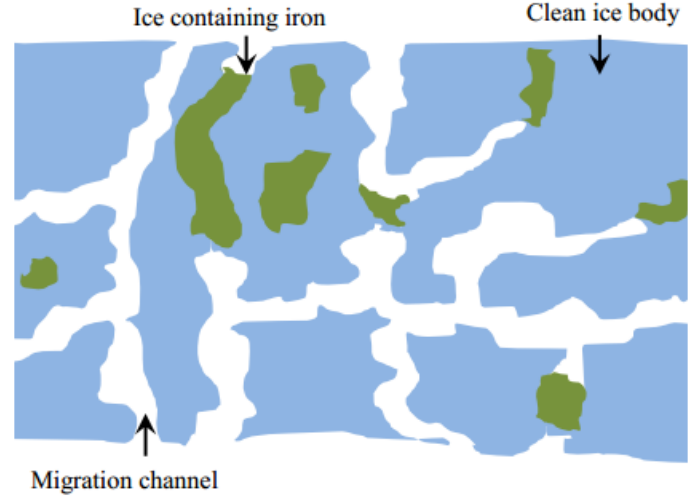
Figure 4. Schematic diagram of ice body profile structure [14].